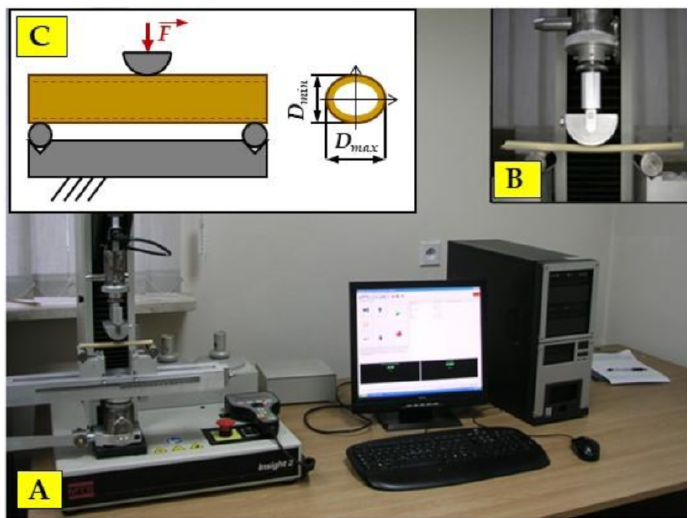
Figure 5. Stand for the three-point bending test: ( A )—MTS testing machine; ( B )—static bending attachment; ( C ) three-point bending scheme and characteristic dimensions of the miscanthus stalk cross-section: D min —minimum stalk diameter, D max —maximum stalk diameter, g —stalk wall thick- ness, a—the length of the semi-minor axis of the ellipse, b—the length of the semi-major axis of the